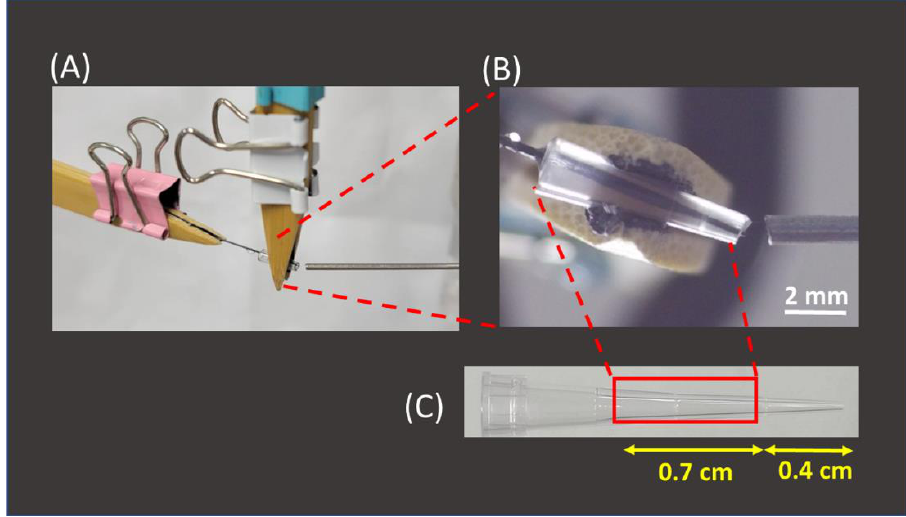
Figure 4. ( A ) Photograph of the SPME-CFI interface setup, ( B ) the zoom-in photograph of the interface, and ( C ) photograph of the pipette tip.